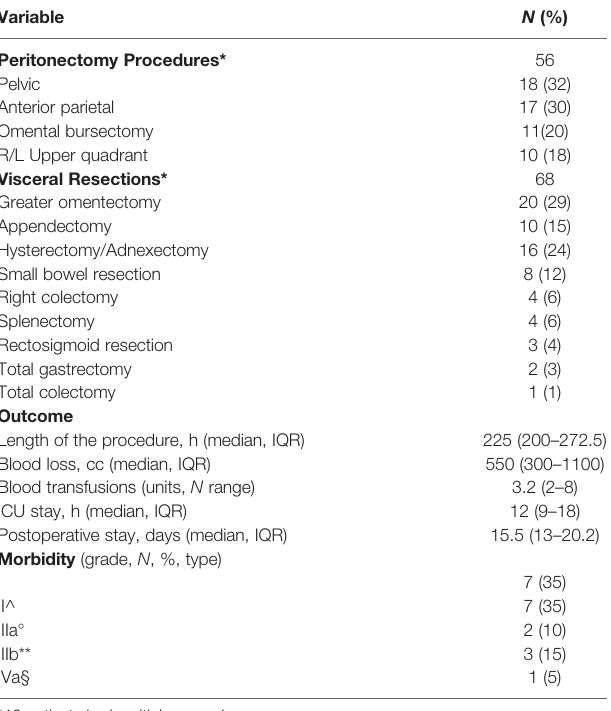
TABLE 2 | Surgical procedures and outcome in the curative intent group (20